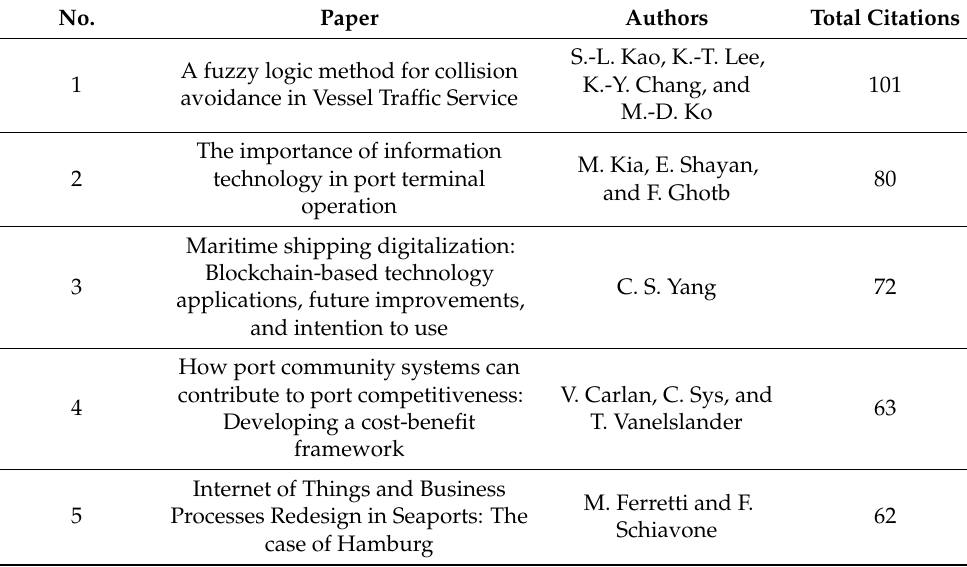
Table 9. Top five categories based on publications.